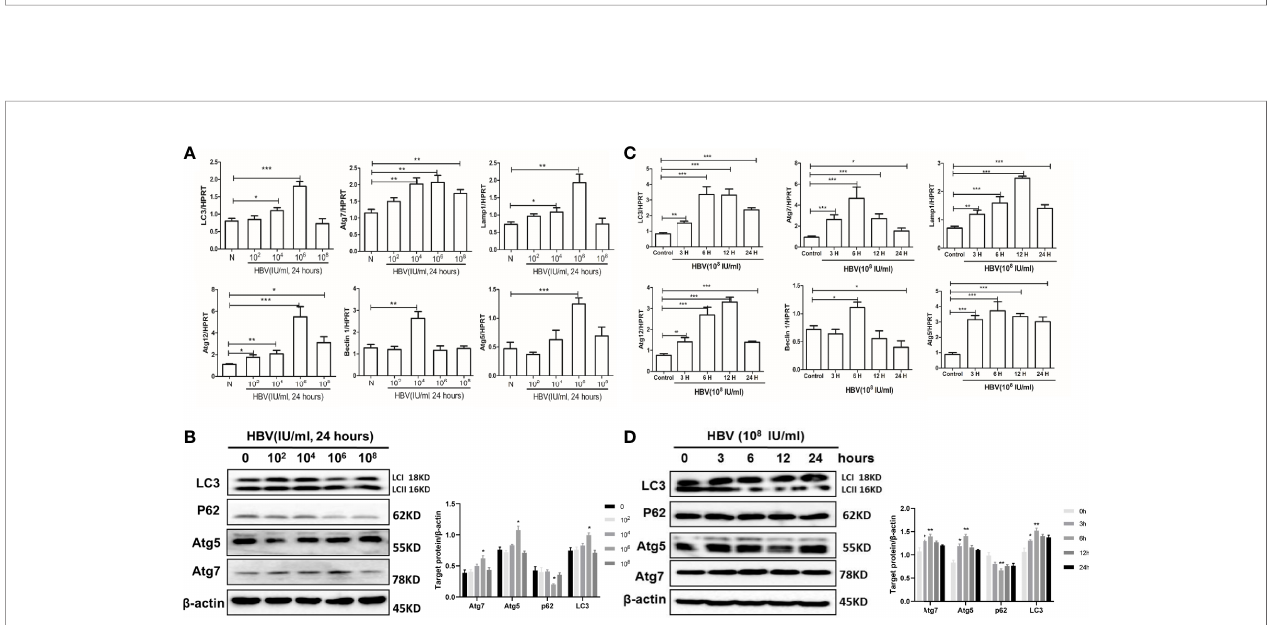
FIGURE 5 | Effects of serum containing HBV on autophagy in JEG-3 cells. JEG-3 cells were treated with the medium containing 10% HBV serum. For different viral loads stimulation, serum samples from healthy volunteers and HBV carriers with different viral loads (10 2 , 10 4 , 10 6 , and 10 8 ) were added and incubated for 48 hours; for different time periods of stimulation, serum from HBV carriers (2.4×10 8 ) was incubated with cells for 3, 6, 12 or 24 hours. (***p<0.001, **p<0.01, *p<0.05). (A) mRNA expression of LC3, ATG7, ATG12, ATG5, Lamp1, Beclin-1 was measured by qPCR after stimulation by different viral load serum. Data are shown as mean ± SD of at least three independent experiments. (B) Protein levels of LC3, p62, ATG5, ATG7 were measured by western blot after stimulation by different viral load serum. The results were repeated by at least three independent experiments. (C) mRNA expression of LC3, ATG7, ATG12, ATG5, Lamp1, Beclin-1 was measured by qPCR after stimulation with HBV serum by different time periods. Data are shown as mean ± SD of at least three independent experiments. (D) Protein levels of LC3, p62, ATG5, ATG7 was measured by western blot after stimulation with HBV serum by different time periods. The results were repeated by at least three independent